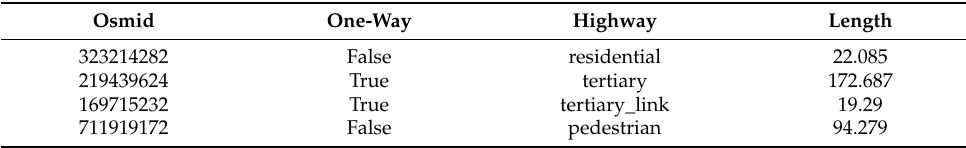
Table 3. Road network edge.